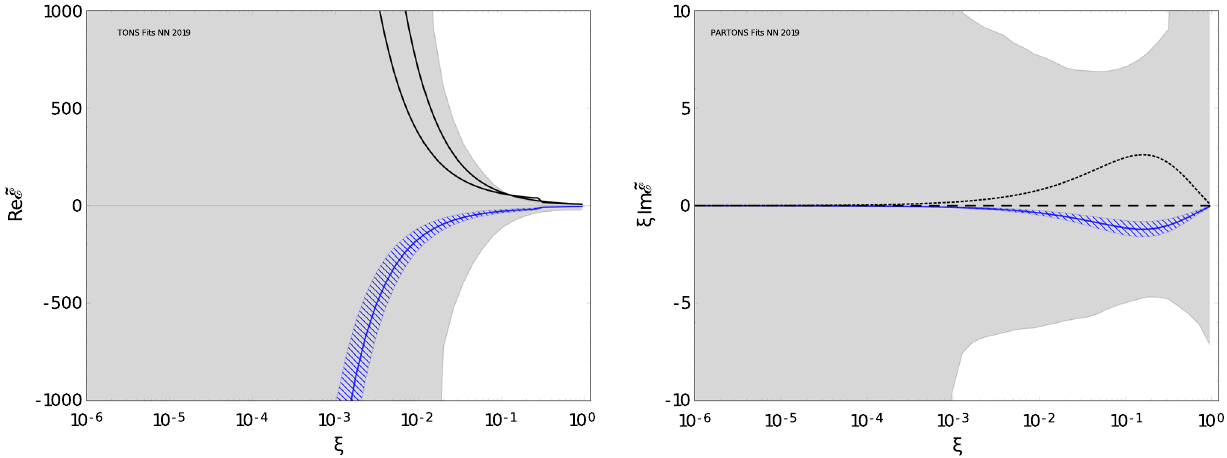
Fig. 19 Real (left) and imaginary (right) parts of the CFF (cid:2) E as a function of ξ for t = − 0 . 3 GeV 2 and Q 2 = 2 GeV 2 . For further description see the caption of Fig. 16